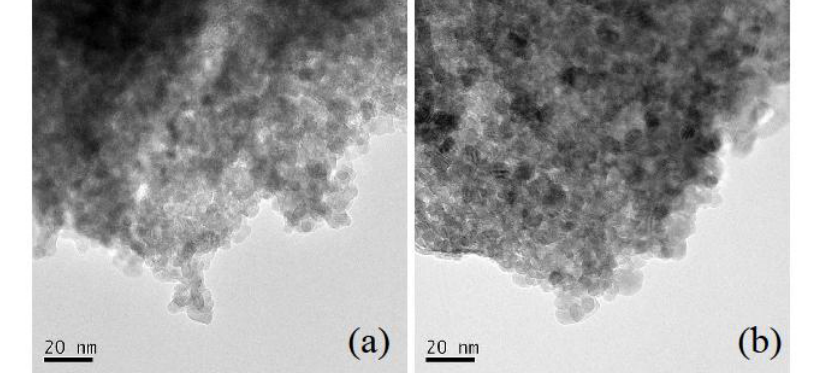
Figure 2. TEM image of the ZnO nanoparticles: ( a ) ZnO nanoparticles without PEG (PEG/Zn 2+ = 0.0[mol/mol]); ( b ) ZnO nanoparticles with PEG (PEG/Zn 2+ =